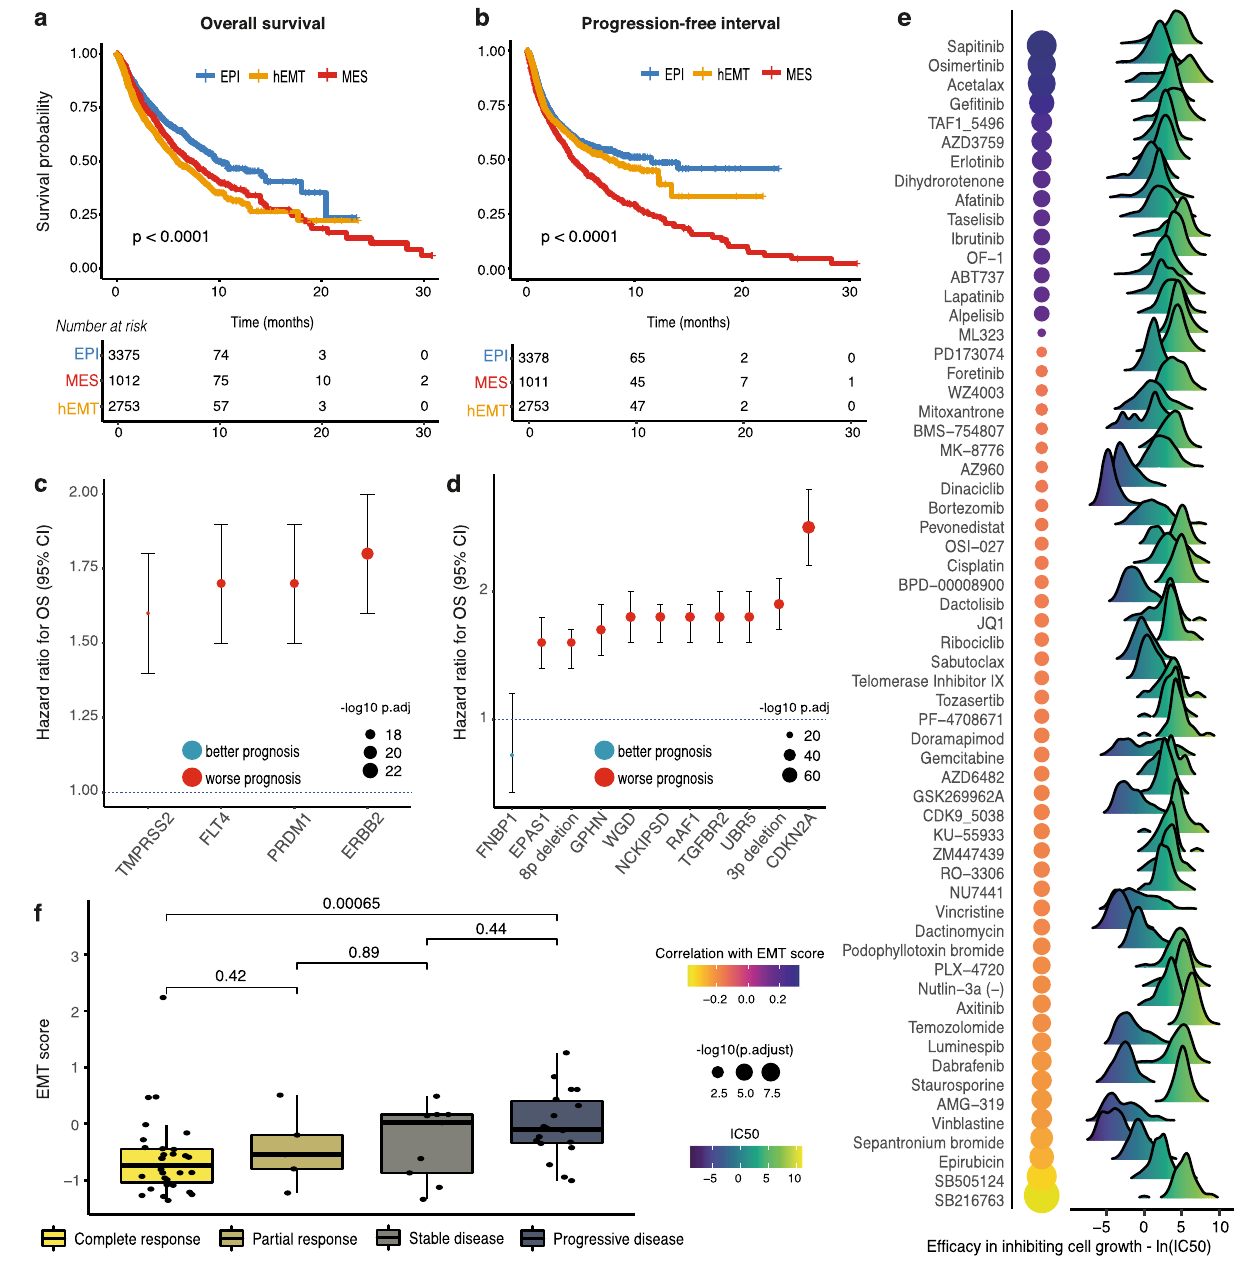
Fig.8|ClinicalrelevanceoftheEMTstates.a Overallsurvivalcomparedbetween MES, hEMT and EPI samples (Cox proportional hazards analysis). Every curve cor- respondstopatientswhosetumoursfallinaspeci fi cEMTcategory,depictedusing different colours. b Progression-free interval compared between the three groups (Cox proportional hazards analysis). c Genomic markers distinguishing between mesenchymalandepithelialstateswithasigni fi cantlyworseorimprovedoutcome ( q <0.001). The mean hazard ratios for overall survival and corresponding con- fi denceintervalsfromtheCoxproportionalhazardsanalysisareindicatedforeach marker.The colourof the dotindicateswhetherthe markerislinked withbetter or worse prognosis. d Genomicmarkersdistinguishing betweenhybrid and epithelial states with a signi fi cantly worse or improved outcome. The meanhazardratios for overallsurvivalandcorrespondingcon fi denceintervalsfromtheCoxproportional hazards analysis are indicated for each marker. The colour of the dot indicates